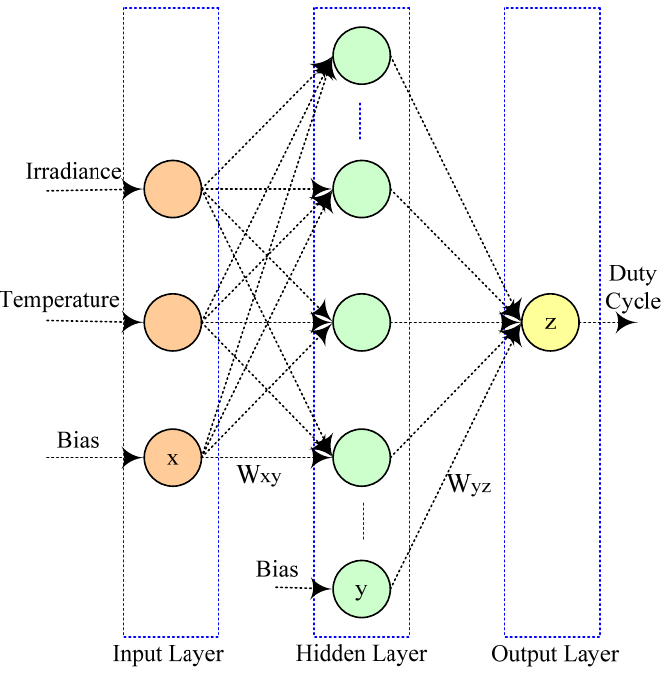
Figure 22. Three-layer structure of ANN [109].